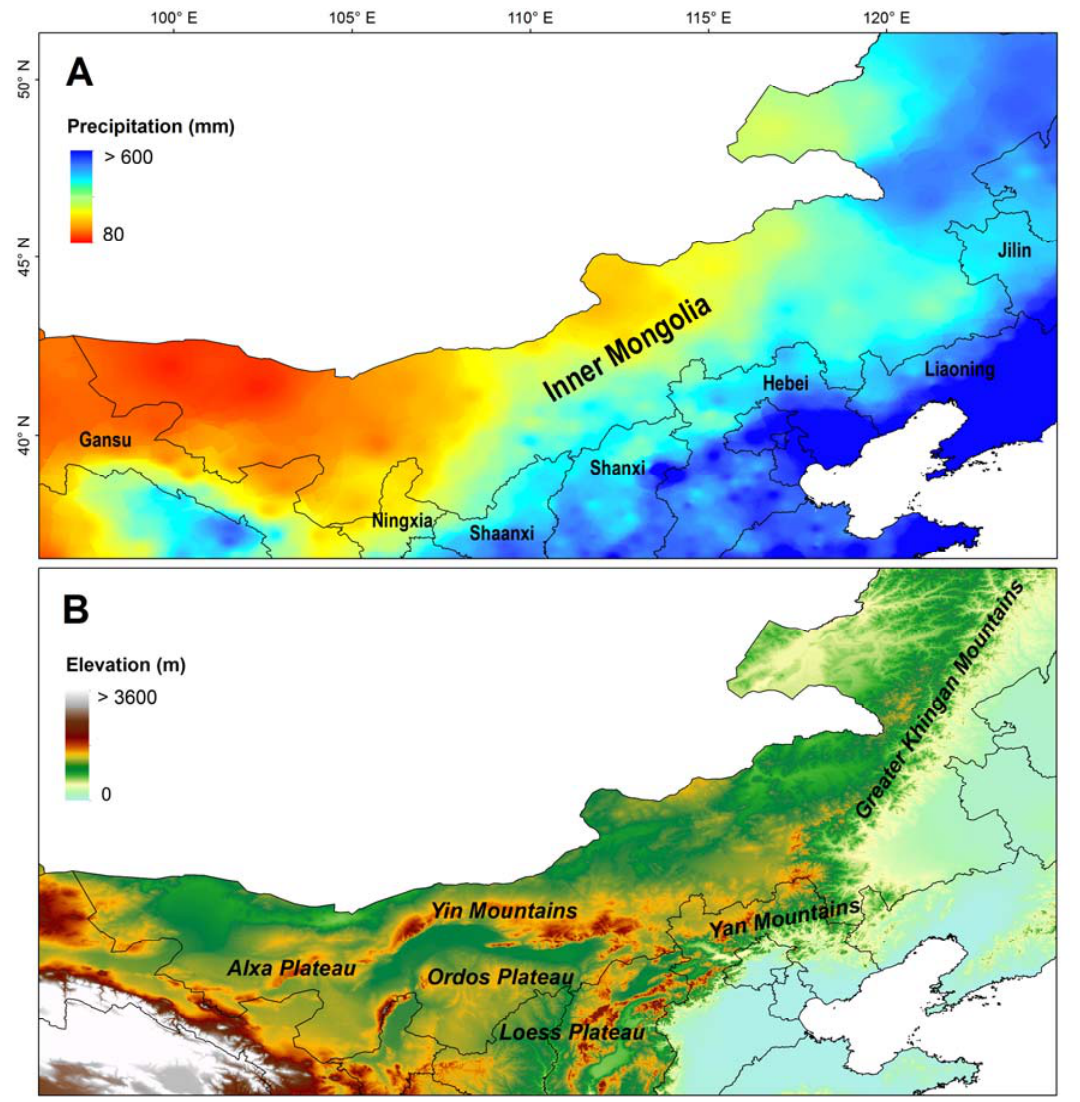
Figure 1. Mean annual rainfall (1999–2006) in Inner Mongolia interpolated from China Meteorological Administration (CMA) data ( A ). Elevation data from Shuttle Radar Topography Mission (SRTM) digital elevation model ( B ). Reclassified land cover map of Inner Mongolia as provided by the Chinese Academy of Science (CAS) [72] for the year 2000. Black frames showing focus regions. Inset showing Inner Mongolia in Asia ( C